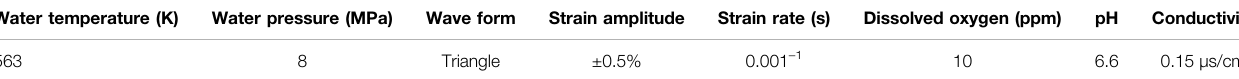
TABLE 1 | The conditions of the corrosion fatigue test.